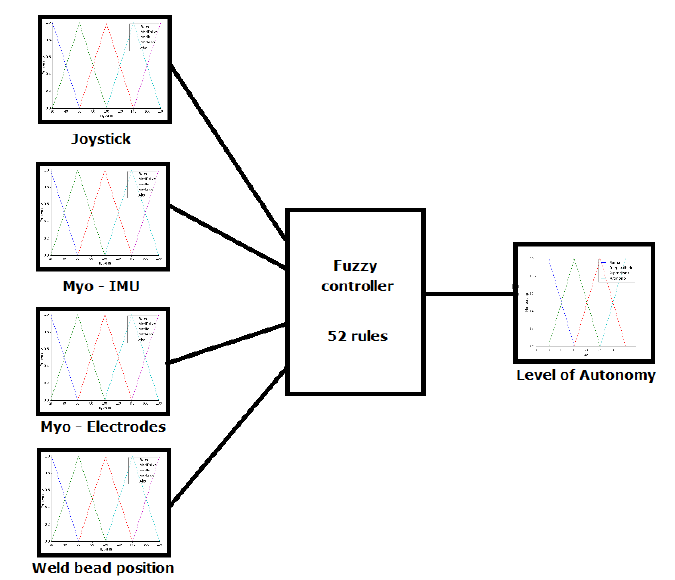
Figure 5. Diagram of the Fuzzy controller implemented.